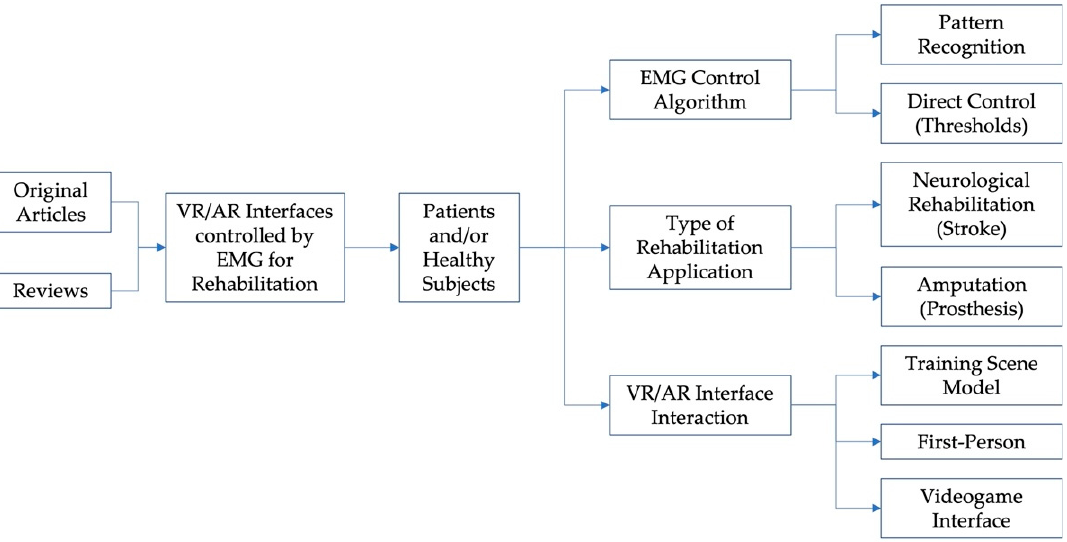
Figure 2. Taxonomy of the SLR: sEMG control algorithms for VR/AR interfaces for motor rehabilitation.